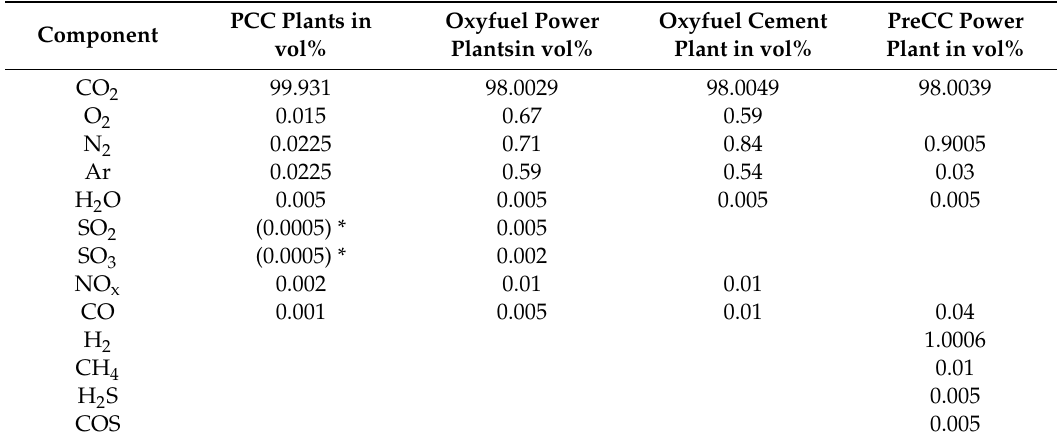
Table 2. Considered CO 2 stream composition of each CO 2 emitter and CO 2 capture technology